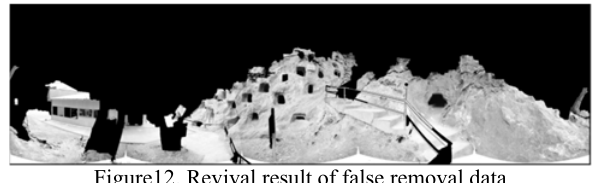
Figure12. Revival result of false removal